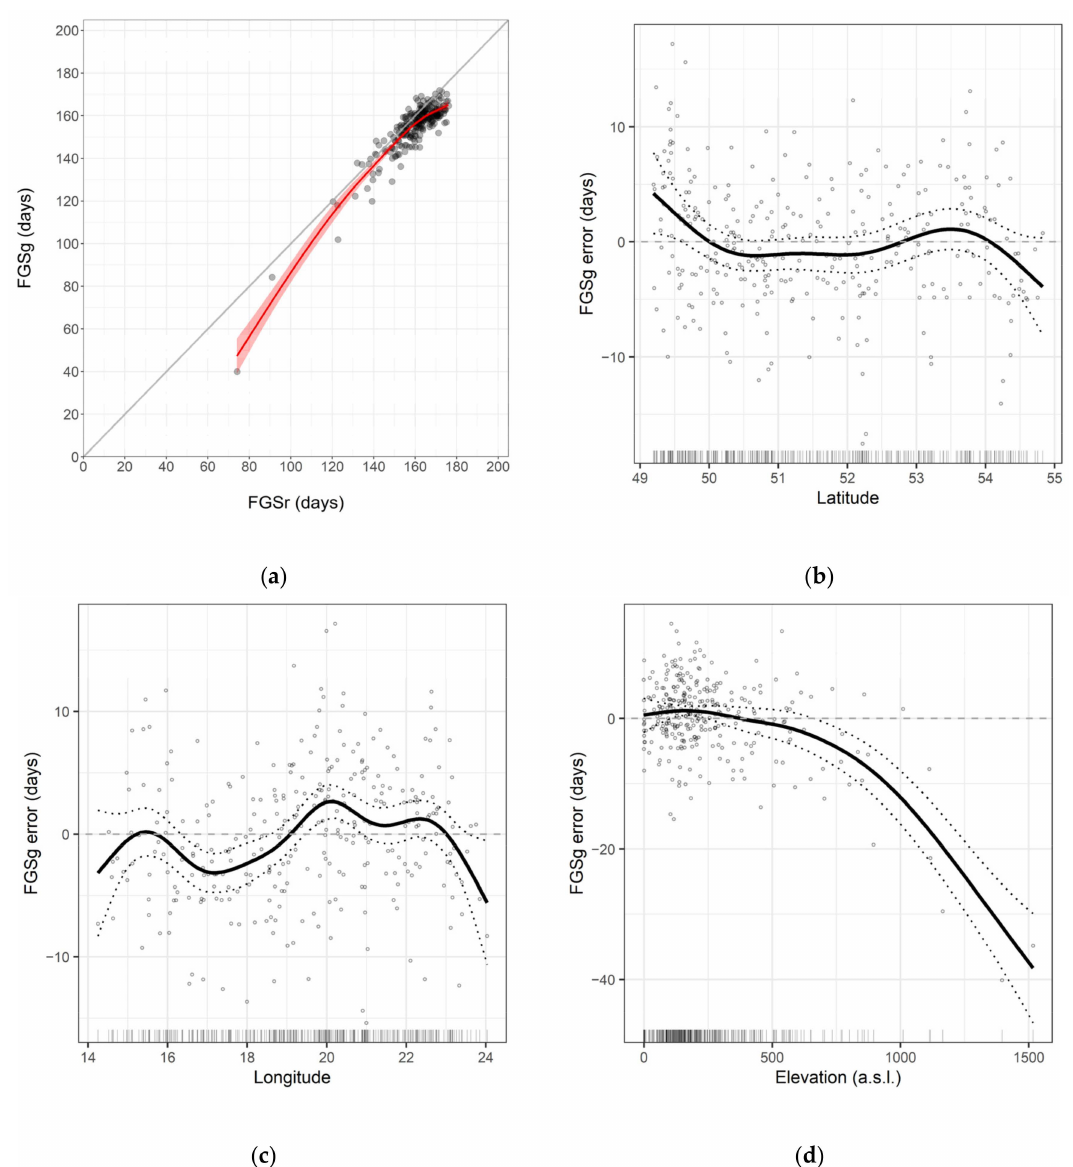
Figure 3. Relationship between FGSg calculated from WorldClim 2.1 grid dataset and FGSr calculated from measurements from 245 meteorological stations for the period 1970–2000 ( a ) and associated error of FGSg determination, according to the developed GAM correction model ( b – d